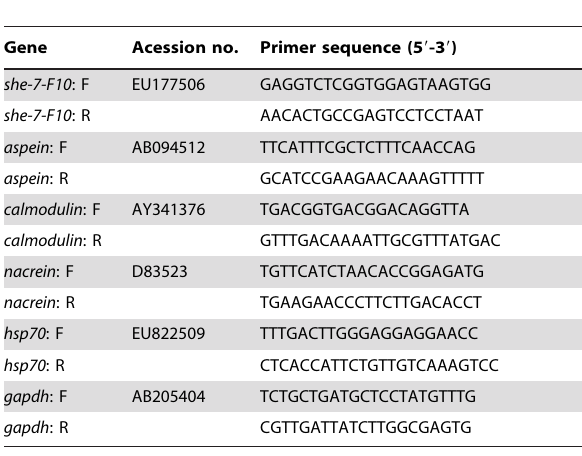
Table 4. Primers sequences of genes used in real-time PCR